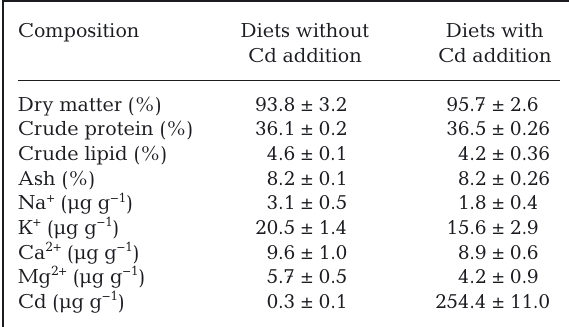
Table 1. Proximate composition and cadmium (Cd) contents of experimental diets (in dry matter). Values are means ±